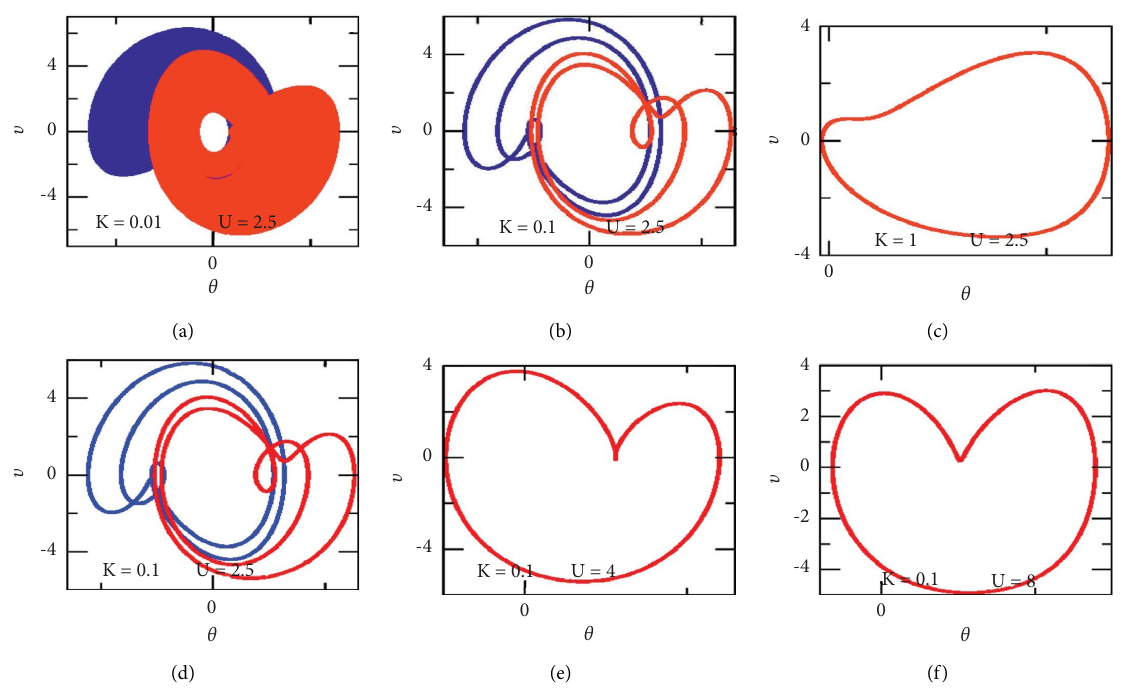
Figure 16: Effect of the parameters K and U on the coexistence of attractors for ϵ � − 1 ; F � 45 . 6 ; α � 10 ; β � 1 ; Ω � 2 ; C 0 . 05 ; M � 0 . 1 ; g � 10. Blue phase portrait corresponds to the initial conditions ( 1 ; − 1 ) , while the red phase portrait corresponds to the initial conditions ( 1 ; 1 . 5 )